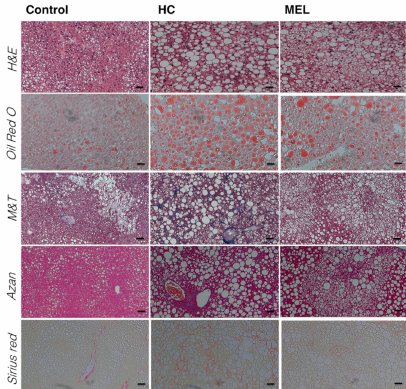
Figure 2. Histological analysis of the liver of the mouse model of a high-fat diet-induced non-alcoholic hepatic steatosis. Scale bar, 50 µ m. Animals were treated with three di ff erent diets: control diet (Control), high-fat and high-cholesterol diet (HC) and high-fat, high-cholesterol + 1% Melon GliSODin ® diet (MEL). Haematoxylin and eosin (H&E) staining; Oil Red O staining; Masson’s trichrome staining; Azan staining; Sirius Red staining.